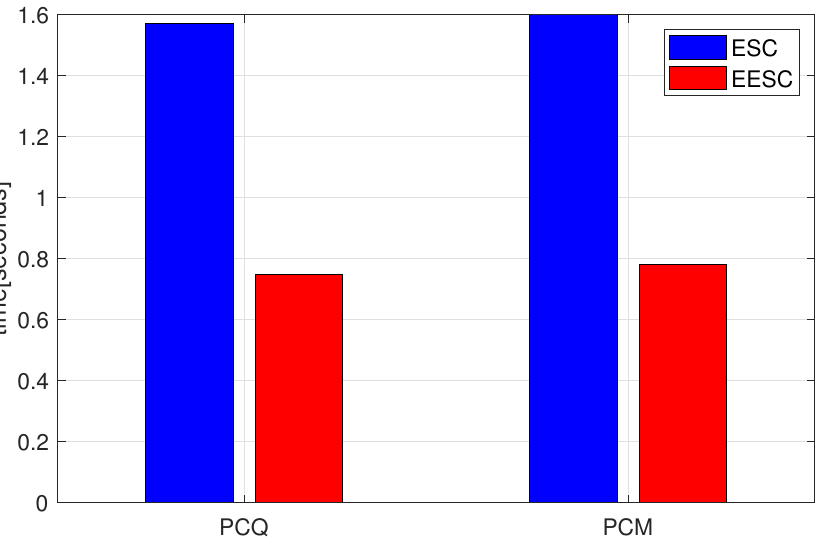
Figure 18. Comparing the average runtimes of the Evolutionary Spectral Clustering (ESC) and the Efficient Evolutionary Spectral Clustering (EESC) algorithms for PCQ and PCM